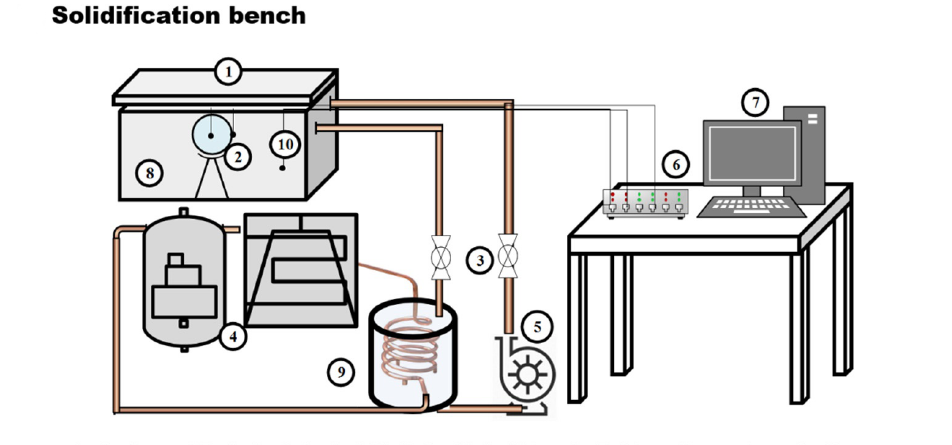
Figure 1. The solidification experimental workbench.